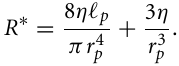
FIGURE 2 | Normalized histograms showing sieve pore radius r p distributions for (A) Cucurbita maxima , (B) Phaseolus vulgaris , (C) Solanum lycopersicum , and (D) Ricinus communis . The solid lines are normal distributions fitted to the